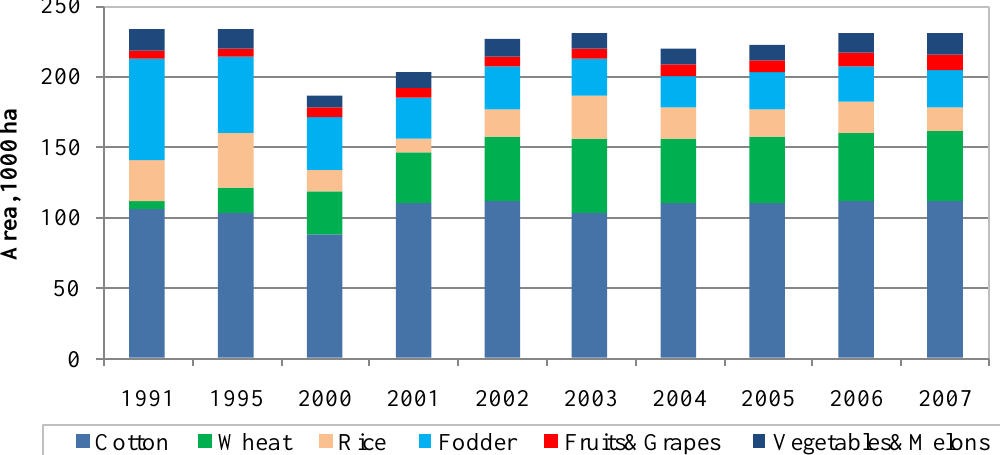
Figure 3. Crop land allocation in the Khorezm region